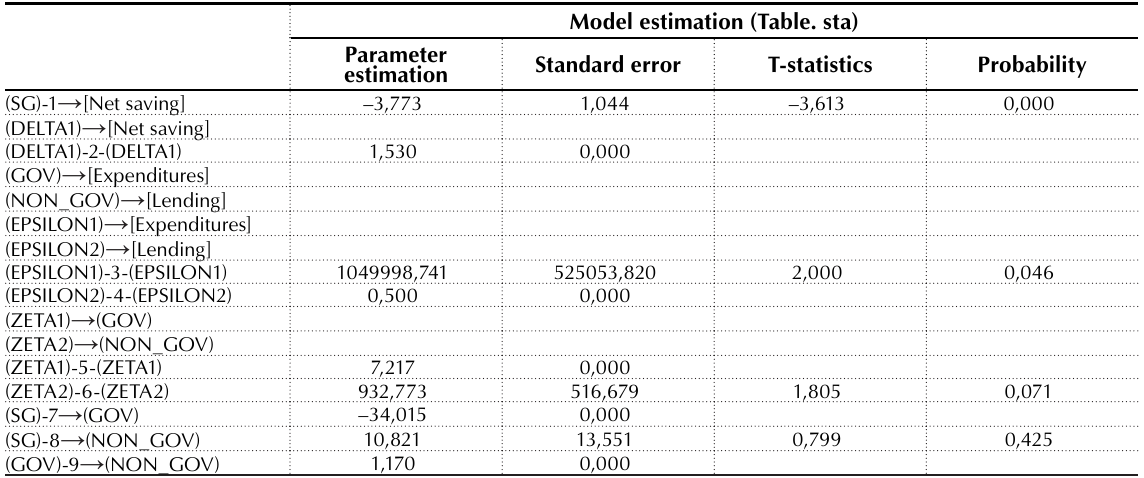
Table 2. Results of structural modeling of the indices relationship for the overall situation in agriculture, state and non-state financing, i.e., lending Model estimation (Table. sta)